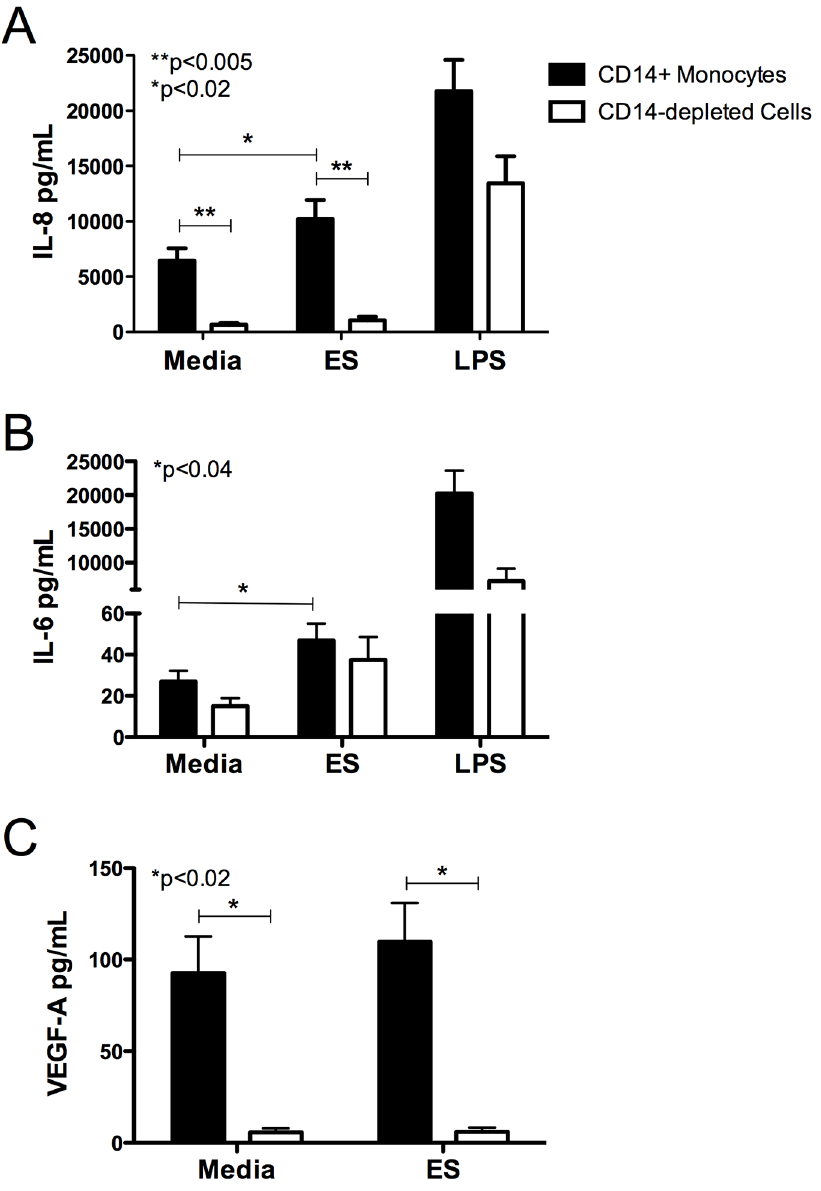
Figure 2. Brugia ES products induce the production of IL-8 and VEGF-A by human CD14 + monocytes. Human CD14 + monocytes were isolated and compared to CD14-depleted cells for IL-8, IL-6 and VEGF-A production in response to worm ES products or LPS. Cell supernatants were assessed for the presence of (A) IL-8 (n=12), (B) IL-6 (n=7) and (C) VEGF-A (n=7) after 72 h of stimulation. Data presented represents the mean + SEM of at least 7 people per factor and comparisons were made using the Signed Rank test. LPS was used as a positive control and stimulated the production of IL-8 (p , 0.003) and IL-6 (p , 0.02) compared to cells cultured in media alone.